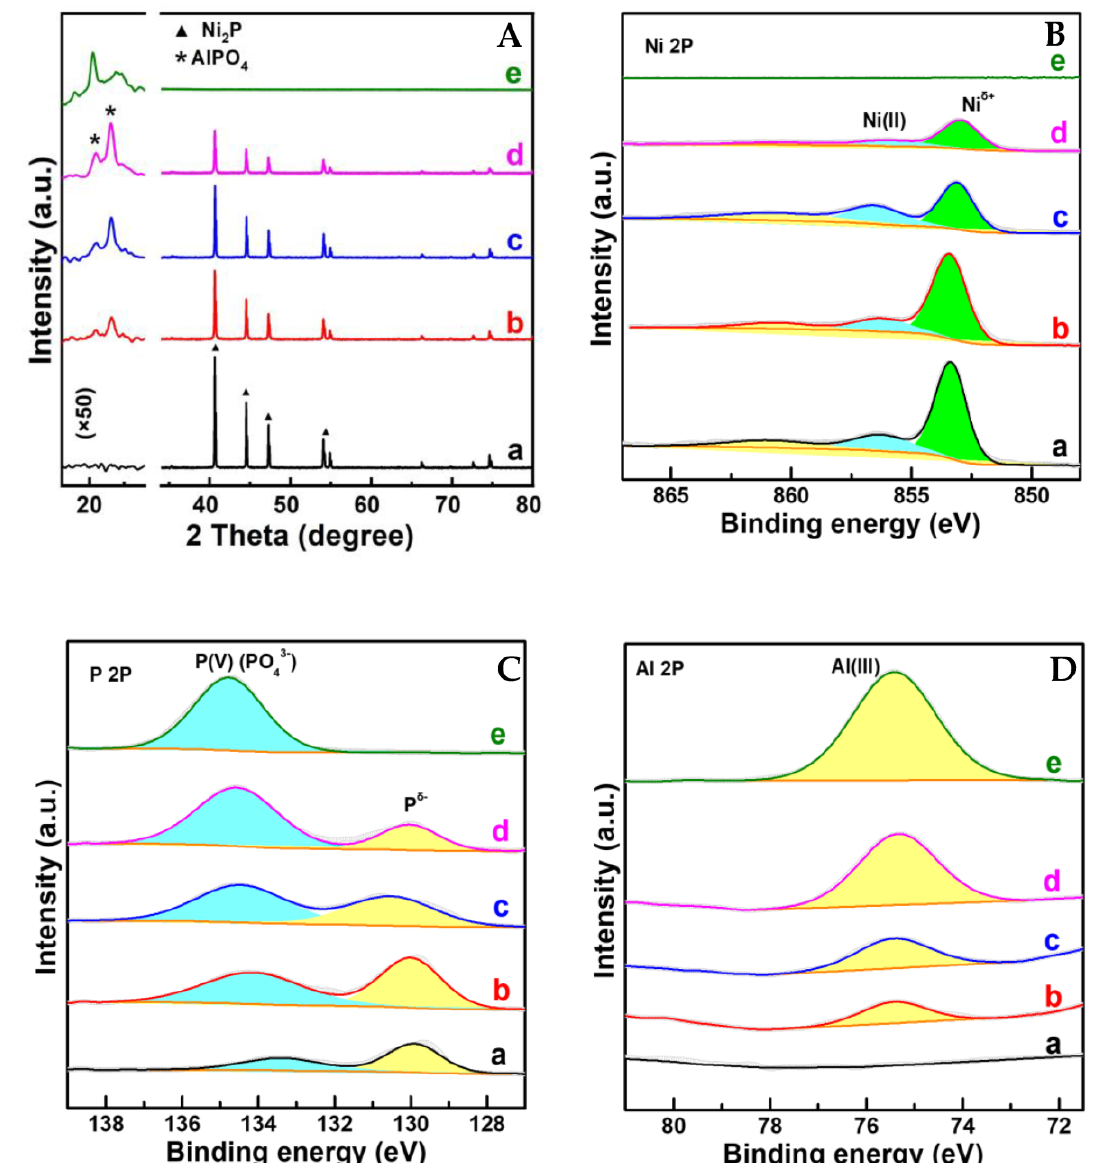
Figure 1. ( A – D ) XRD patterns and XPS spectra of samples. a. Ni 2 P; b. (AlPO 4 ) 0.05 /Ni 2 P; c. (AlPO 4 ) 0.1 /Ni 2 P; d. (AlPO 4 ) 0.2 /Ni 2 P; e. AlPO 4 . Note: The intensity of pattern at 2 theta around 20 degree in ( A ) was enlarged as 50 times as that of original pattern. Table 1. Surface physical chemistry parameters of typical catalysts and their performances. Surface Catalysts